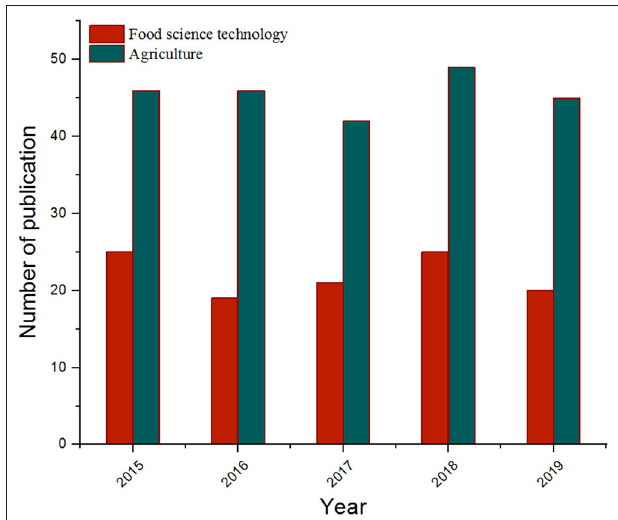
FIGURE 1 | The growth trend of published articles on MIPs in food science technology and agriculture during 2015–2019 (data collected from Web of